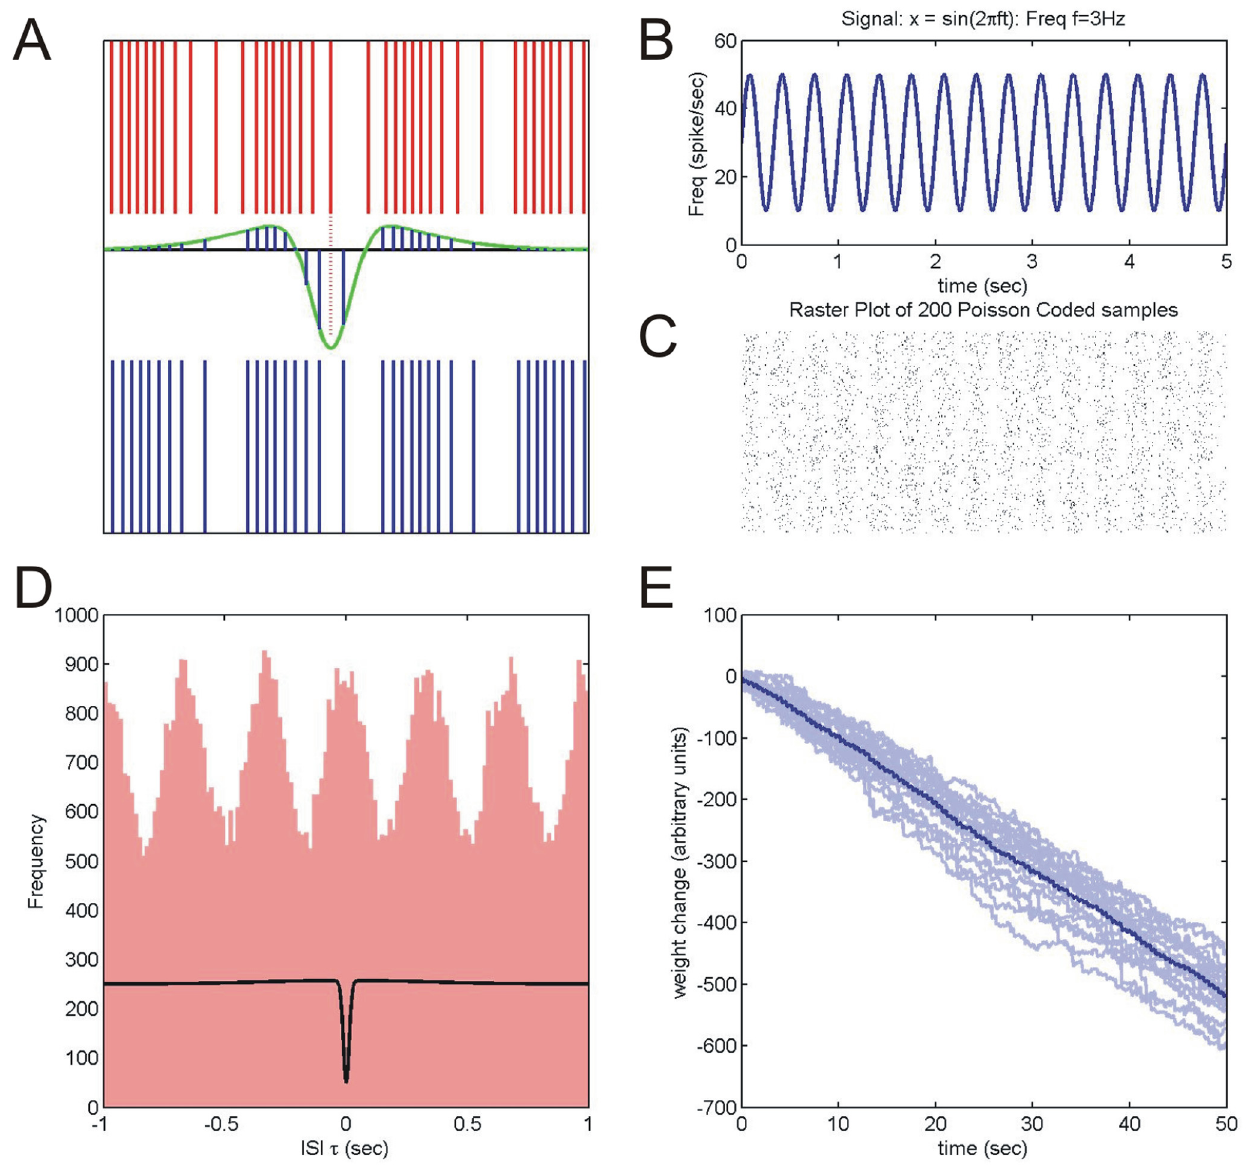
Figure 9. iSTDP for stochastic inputs. A: The top (red) spike train represents vestibular input x and the bottom (blue) spike train represents inhibitory cerebellar input y . The green curve shows an iSTDP profile (corresponding to a difference of Gaussians kernel { K t ð Þ as described in Methods) chosen to demonstrate both LTP and LTD lobes clearly. The total contribution of a given vestibular spike, for example the one extended by the red dotted line, to synaptic weight change is calculated as follows: its timings t ij with respect to all cerebellar spikes are determined. The contribution of each of these spike pairs to weight change is proportional to { K t ij (cid:2) (cid:3) (equation (3)), these values are shown graphically as the blue segments under the iSTDP profile centered at the chosen vestibular spike. The sum of all these segments is the weight change ‘caused’ by that vestibular spike. B: A sinusoidal vestibular input modulating at 3 Hz, represented as a variation in firing rate with mean rate 30 Hz and amplitude 20 Hz. C: A raster plot of 200 different Poisson coded samples of the sinusoidal signal (for Poisson coding the probability of a spike in a short interval dt is Fdt where F is the firing rate to be coded). It is clear that the coding scheme is asynchronous, i.e. the timing of individual spikes is not well- determined. D: A histogram of all interspike intervals t (between vestibular and cerebellar spikes, see Methods) for a single 50 s x , y input pair modulated in phase at 3 Hz and Poisson coded as in Fig. 2. Despite the fact that individual spikes are not precisely timed, there is a clear modulation of the ISI histogram at 3 Hz with a peak at zero ISI. The experimentally constrained iSTDP profile from Fig. 3H is overlaid on the histogram. E: Cumulative weight change calculated for 20 pairs of 50 s samples of vestibular and cerebellar input. There is a stochastic but consistent weight decrease. The mean weight change (dark blue curve) is also shown.